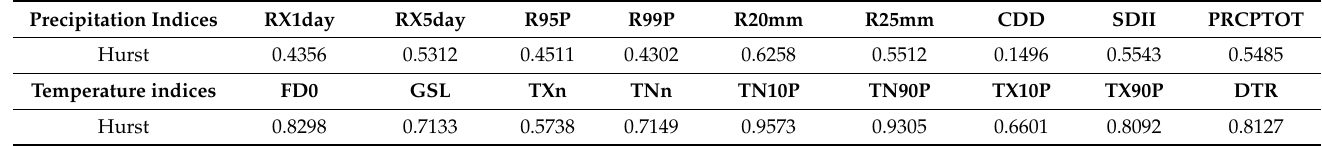
Table 4. Hurst index of Beijing–Tianjin–Hebei extreme climate